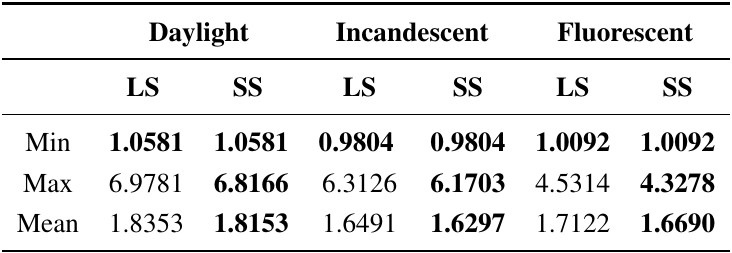
Table 4. ∆ E error for three different illuminants on the Simon Fraser dataset (Least-Squares (LS), Spherical Sampling (SS)).